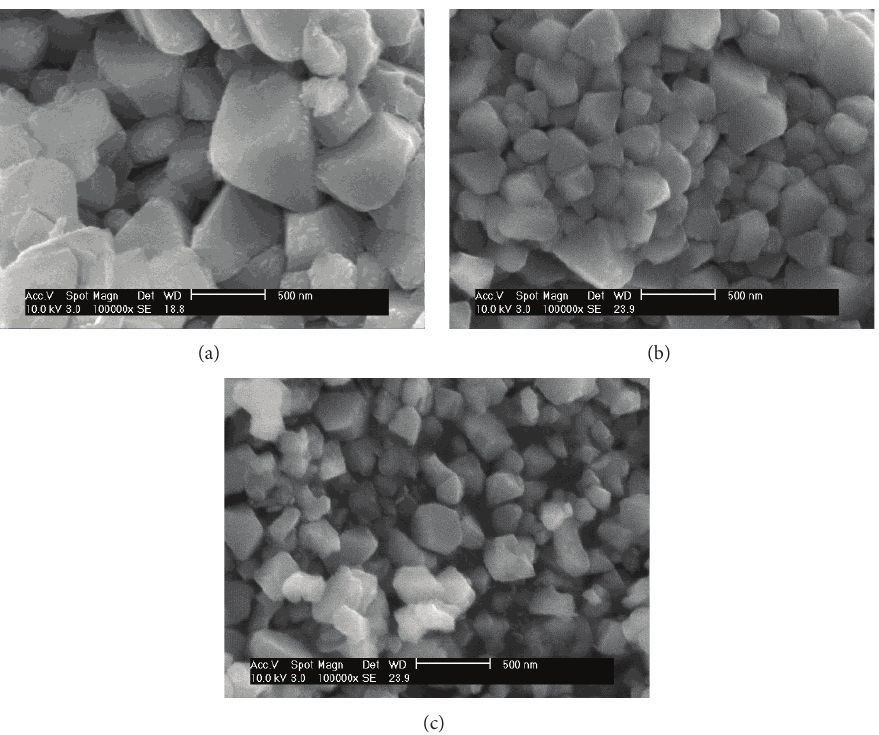
Figure 2: Scanning electron micrograph obtained for LiNi 0.7